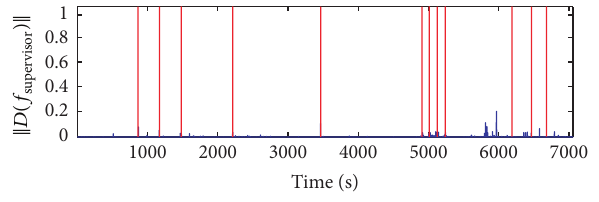
)‖ along the sequence of Figure 18: Evolution of ‖𝐷(𝑓 supervisor missions. Values larger than 1 mean that the mission was not successfully completed due to the performance timing index